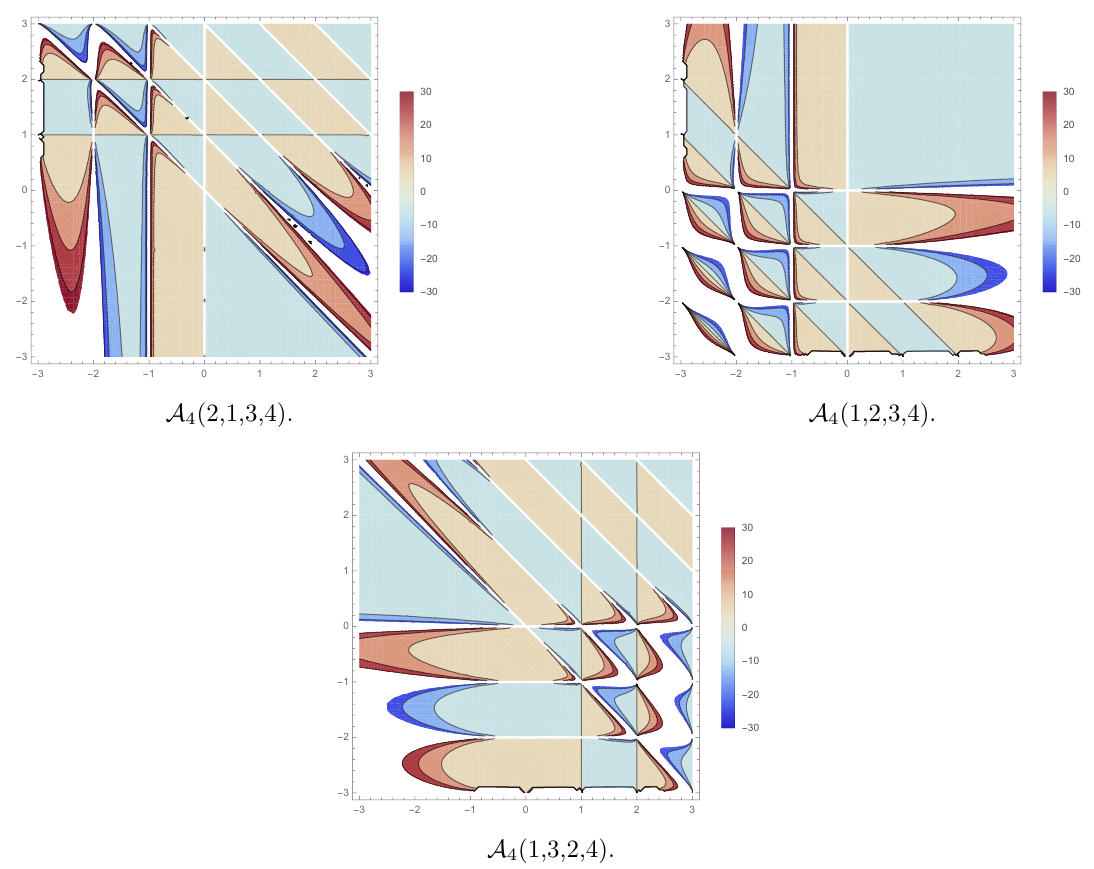
Figure 5. Contour plots for three partial gluon amplitudes with 2 α 0 k 1 · k 2 and 2 α 0 k 2 · k 3 being X-axis and